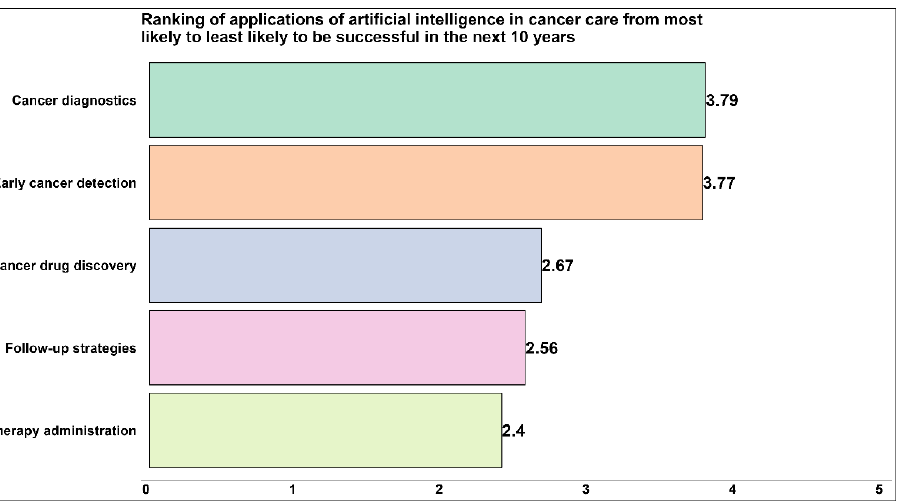
Figure 3. Average ranking of AI applications most likely to be successful in cancer care in the next ten years. Ranking on a 5-point scale, where 1 is the most likely and 5 is the least likely. SurveyMonkey calculated the ranking result. Applying weights in reverse, SurveyMonkey calculates the average ranking for each respondent’s choice to determine the most preferred choice overall (SurveyMonkey: https://help.surveymonkey.com/en/surveymonkey/create/ranking-question/, accessed on 20 November